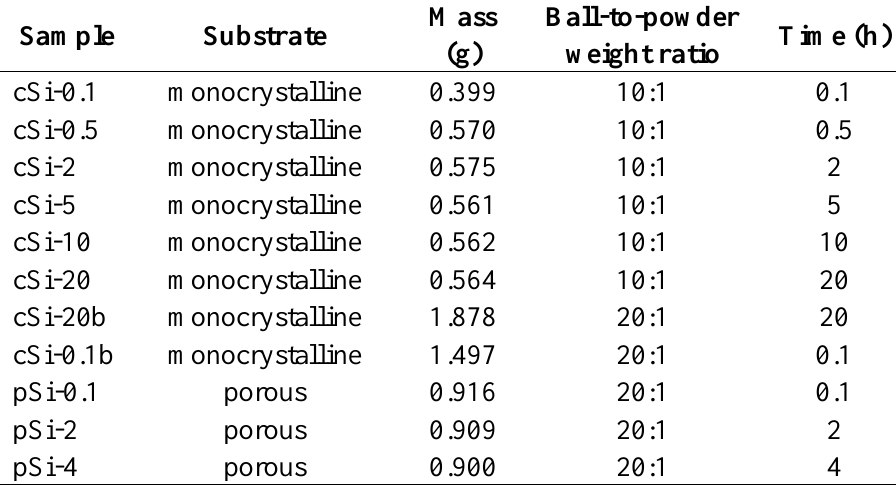
Table 1. Experimental working conditions.